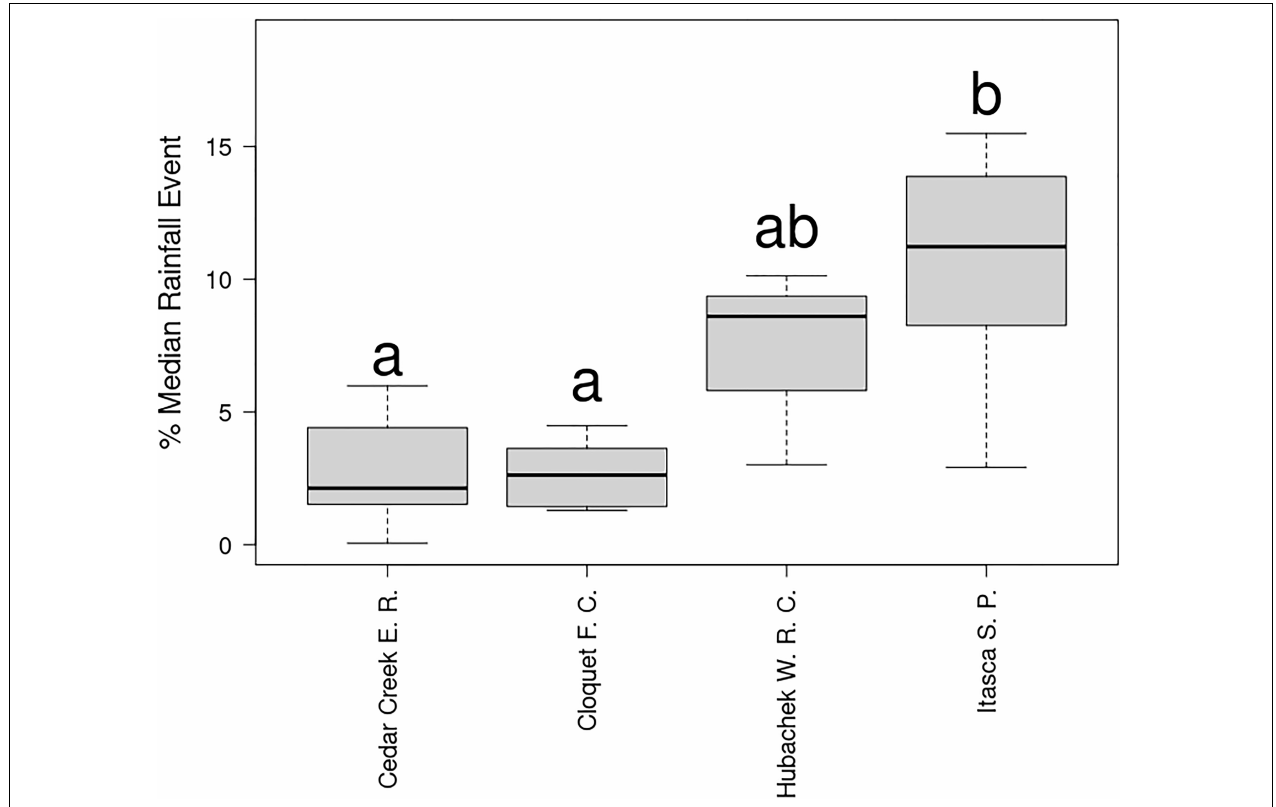
FIGURE 4 | Potential canopy water storage by epiphytes as a proportion of median rainfall event size (median 24 h precipitation 2010–2020) at study sites. Letters indicate significantly different groups ( p < 0.05) according to Tukey HSD post-hoc